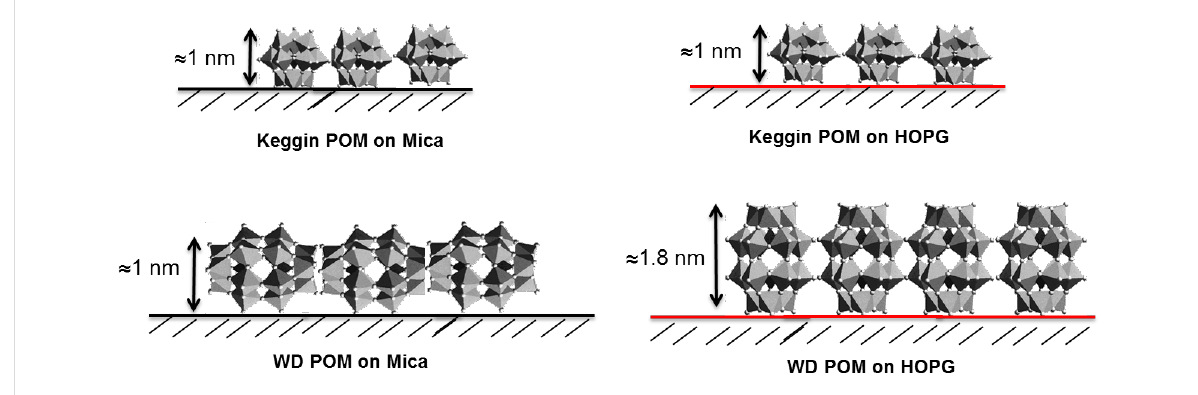
Figure 2: Schematic representation of the arrangement of Keggin and WD POM on mica and HOPG surfaces.